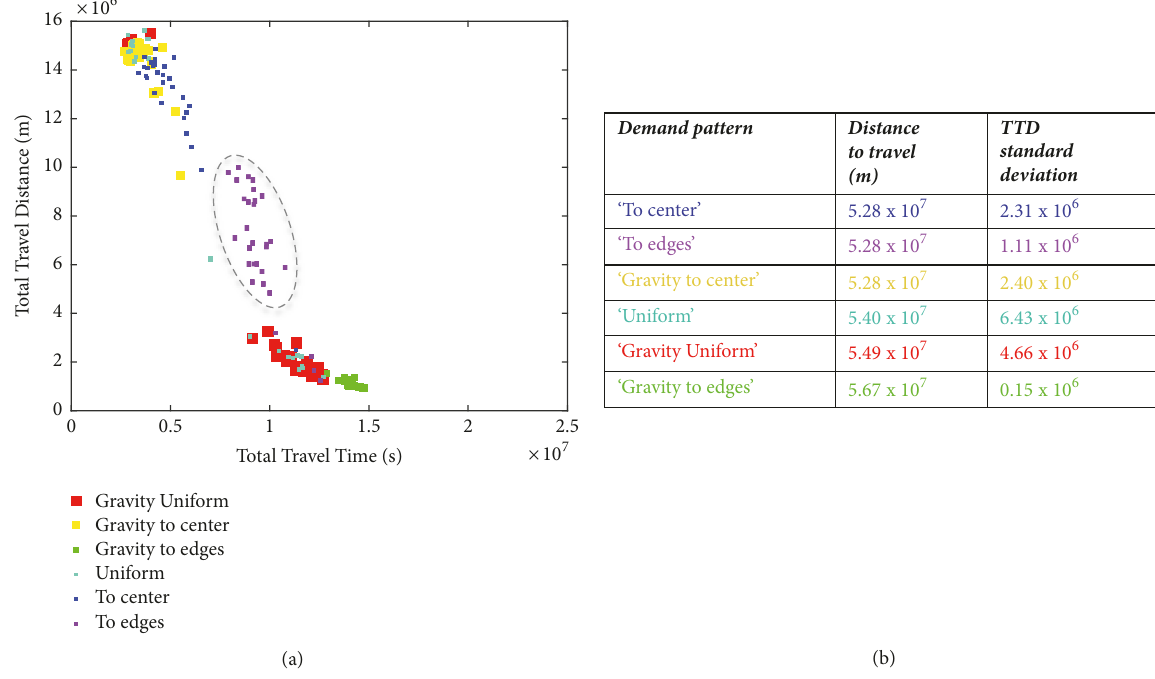
Figure 5: (a) Final network states with demand level 4 colored by pattern and (b) table of metrics by